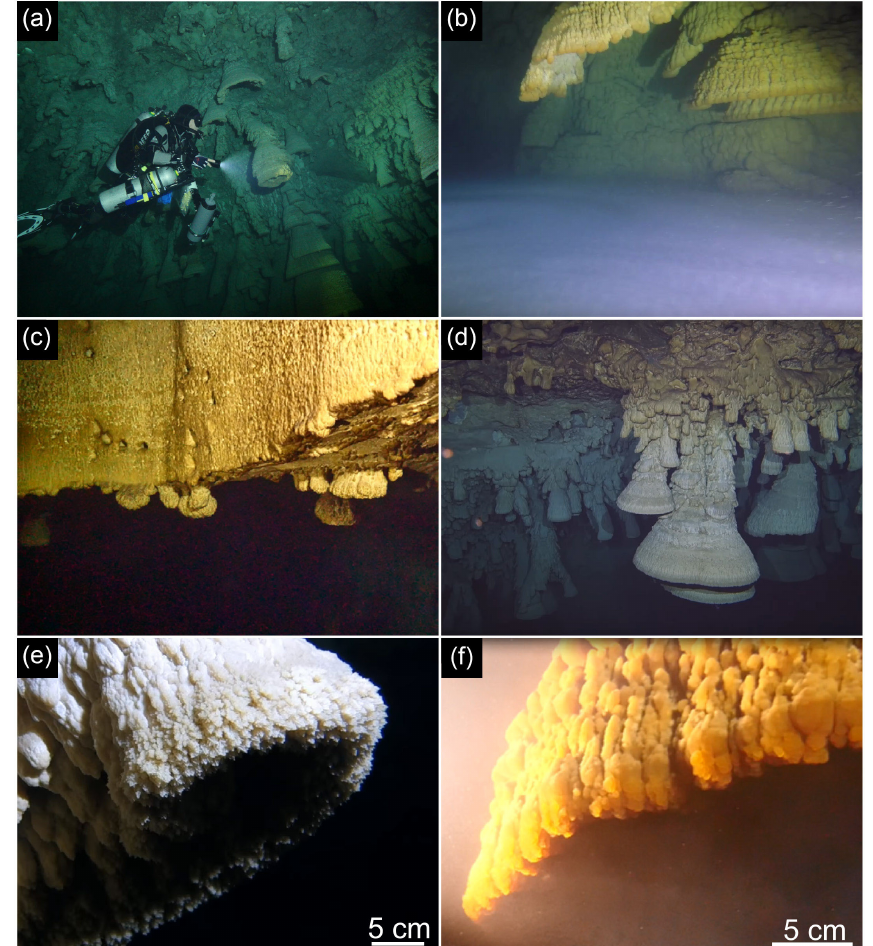
Figure 2. Technical diver in El Zapote cenote during a sample-collecting dive carrying the Niskin bottle, sample containers and the multi- parameter sonde attached to the sidemount gas bottle (a) . Turbid layer immediately above the halocline forming a distinct horizontal white cloud at around 36m water depth (b) . Transition of cenote shaft to the open dome-shaped cavern at 28m water depth (c) , where the vertical wall of the cenote shaft is devoid of Hells Bells speleothems (upper part of c ), whereas small specimens of Hells Bells grow down from the horizontal ceiling below (lower part of c ). Brown-colored manganese oxide coatings on host rock carbonates and Hells Bells speleothems reach down from 28m water depth to around 30m water depth at the transition of the cenote shaft to the wide dome-like cavern (c, d) . Below around 30m water depth, Hells Bells speleothem and host rock carbonate surfaces are devoid of brownish manganese oxide coatings. They are white to light-gray colored revealing a distinct horizontal boundary (d) . Close-up shot of the lowermost calcite rim of a Hells Bells speleothem at around 32–35m water depth showing millimeter-sized calcite crystals (e)